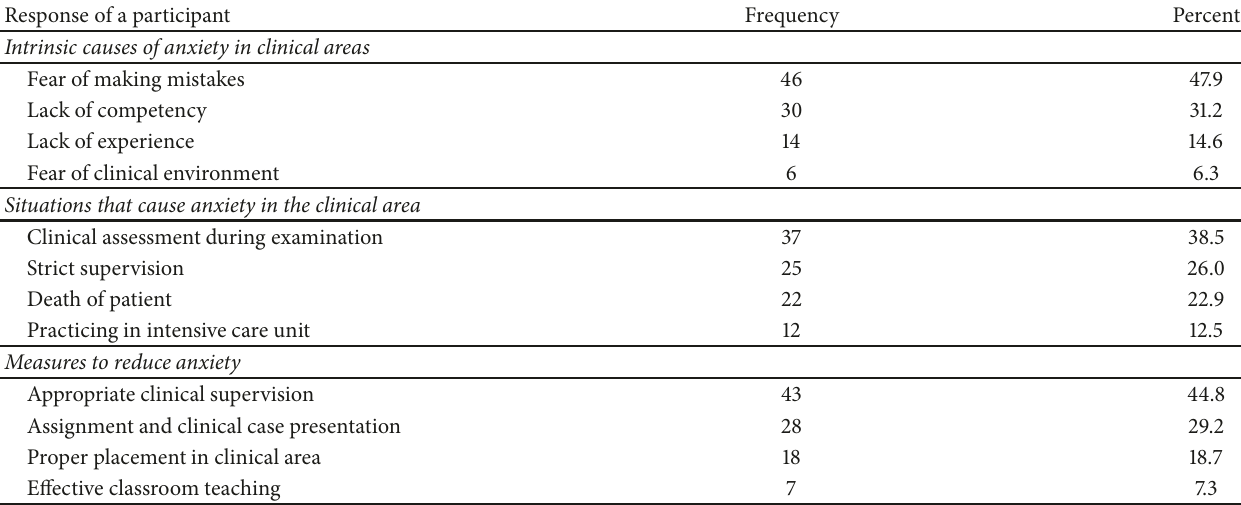
Table 5: Causes and measure to reduce anxiety by nursing students (n=96).